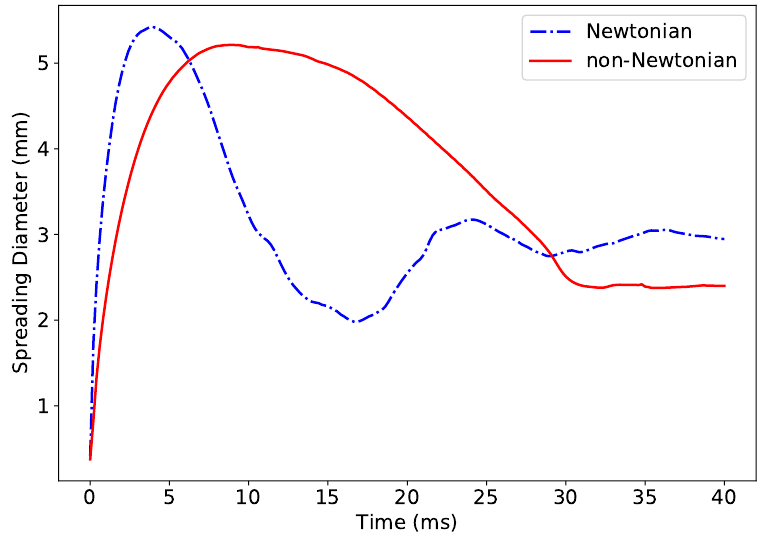
Figure 6. A comparative simulation of droplet impact of Newtonian and non-Newtonian fluids used in the present study.